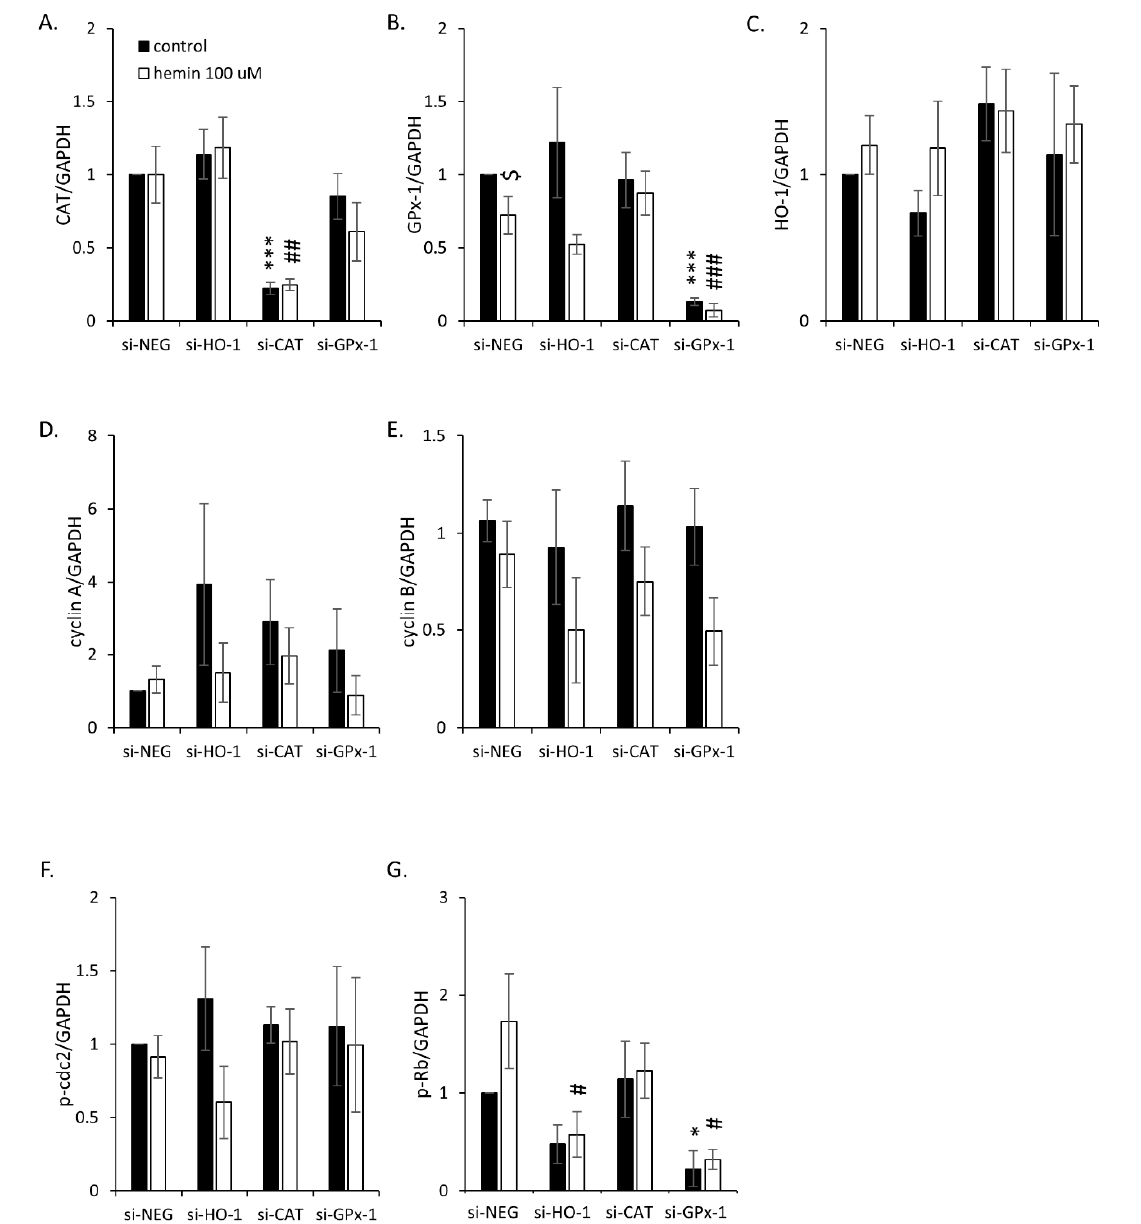
Figure A5. Evaluation of the protein expression in HCT116 cells, where genes encoding antioxidative enzymes HO-1, CAT, and GPx-1 were silenced with the use of siRNAs: antioxidative and proliferation markers. Cells were treated with 2.5 µM IRINO and exposed to 100 µM hemin. Control cells were subjected to IRINO and NaOH. Cells were incubated with drugs for 24 h; after that time, the medium was removed and the cells were cultured in a drug-free medium for 4 days. Quantification is based on the densitometry analysis performed with the use of ImageJ software. Data are shown as the ratio of the protein amount to respective protein loading control (GAPDH): ( A ) CAT; ( B ) GPx-1; ( C ) HO-1; ( D ) cyclin A; ( E ) cyclin B; ( F ) p-cdc2; ( G ) p-Rb. Each bar represents mean ± SEM, n ≥ 3; * p < 0.05, *** p < 0.001—vs. siNEG control; # p < 0.05, ## p < 0.01, ### p < 0.001—vs. siNEG hemin 100 µM ; $ p < 0.05—control vs. hemin 100 µM.